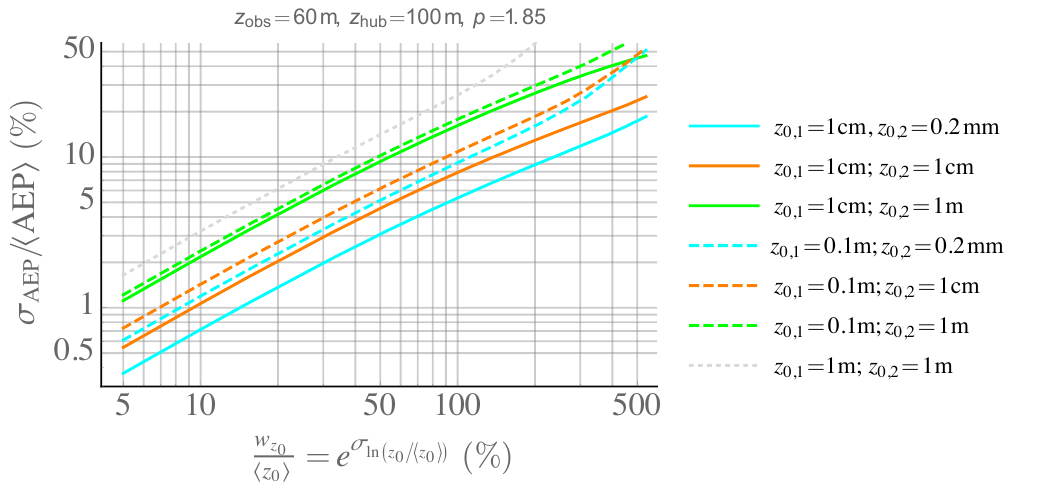
Figure 8. Uncertainty in AEP vs. (relative) roughness uncertainty due to the combined effect of observation and prediction site roughness- uncertainty; independent log-normal roughness distributions assumed, with dimensionless width w z for different combinations of (cid:104) z 0 , 1 (cid:105) and (cid:104) z 0 , 2 (cid:105) . Case shown for p = 1 . 85, i.e., AEP = U 1 . 85 as in Fig.